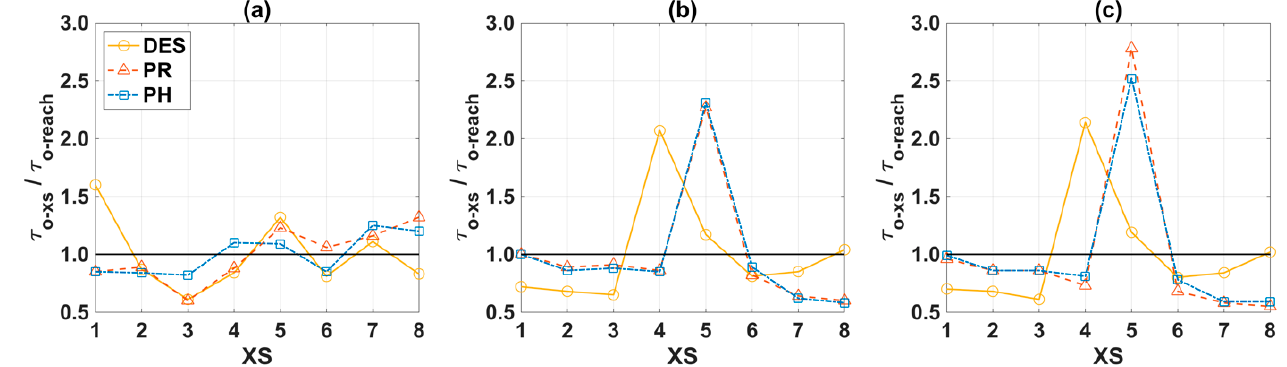
Figure 5. Streamwise variation of τ o at each cross-section ( τ o-xs ) normalized by the reach-averaged τ o ( τ o-reach ) for the Design (DES), Post-Restoration (PR), and Post-Hurricane (PH) geometries as predicted by ( a ) BSTEM, ( b ) HEC-RAS 1D, and ( c ) HEC-RAS 1D & BSTEM.